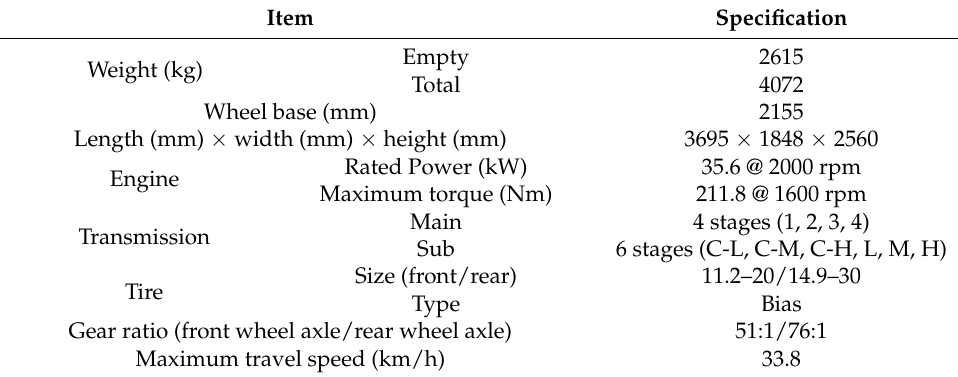
Table 1. Specification of the agricultural tractor.